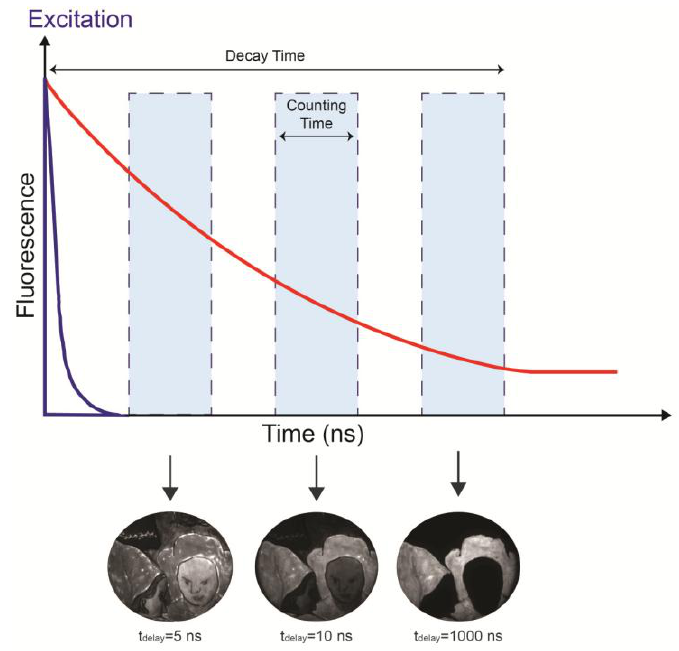
Figure 1. A timing diagram showing pulsed laser excitation, luminescent emission, and operation of the intensifier gate. The acquisition of luminescent images at different delays with respect to the laser pulse (purple). The intensity of the luminescence (red) decreases in time. The images recorded highlight the presence of a long-lived emission (>1,000 ns). Intensity in insets has been rescaled to fill the dynamic range of each